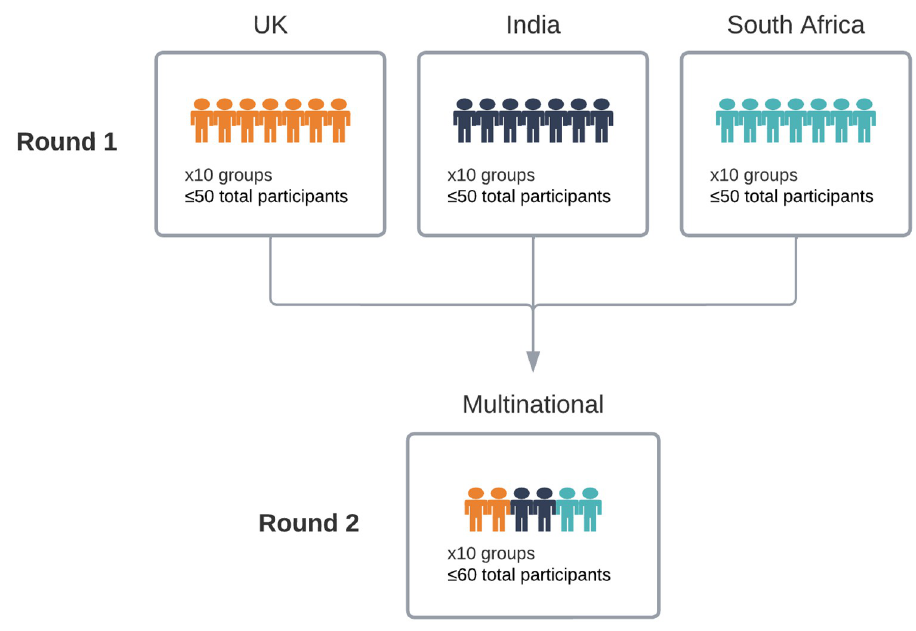
Fig 3. Two-round, multi-country deliberation